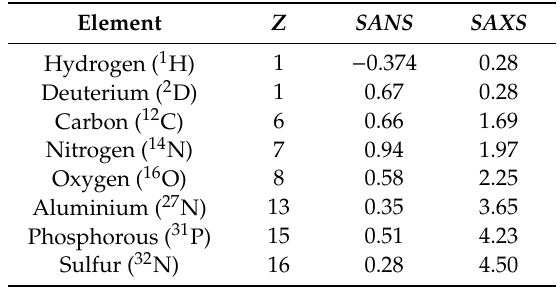
Table 1. Examples of the SANS and SAXS atomic coherent scattering lengths b i (10 − 12 cm) of relevant elements of the biological systems.